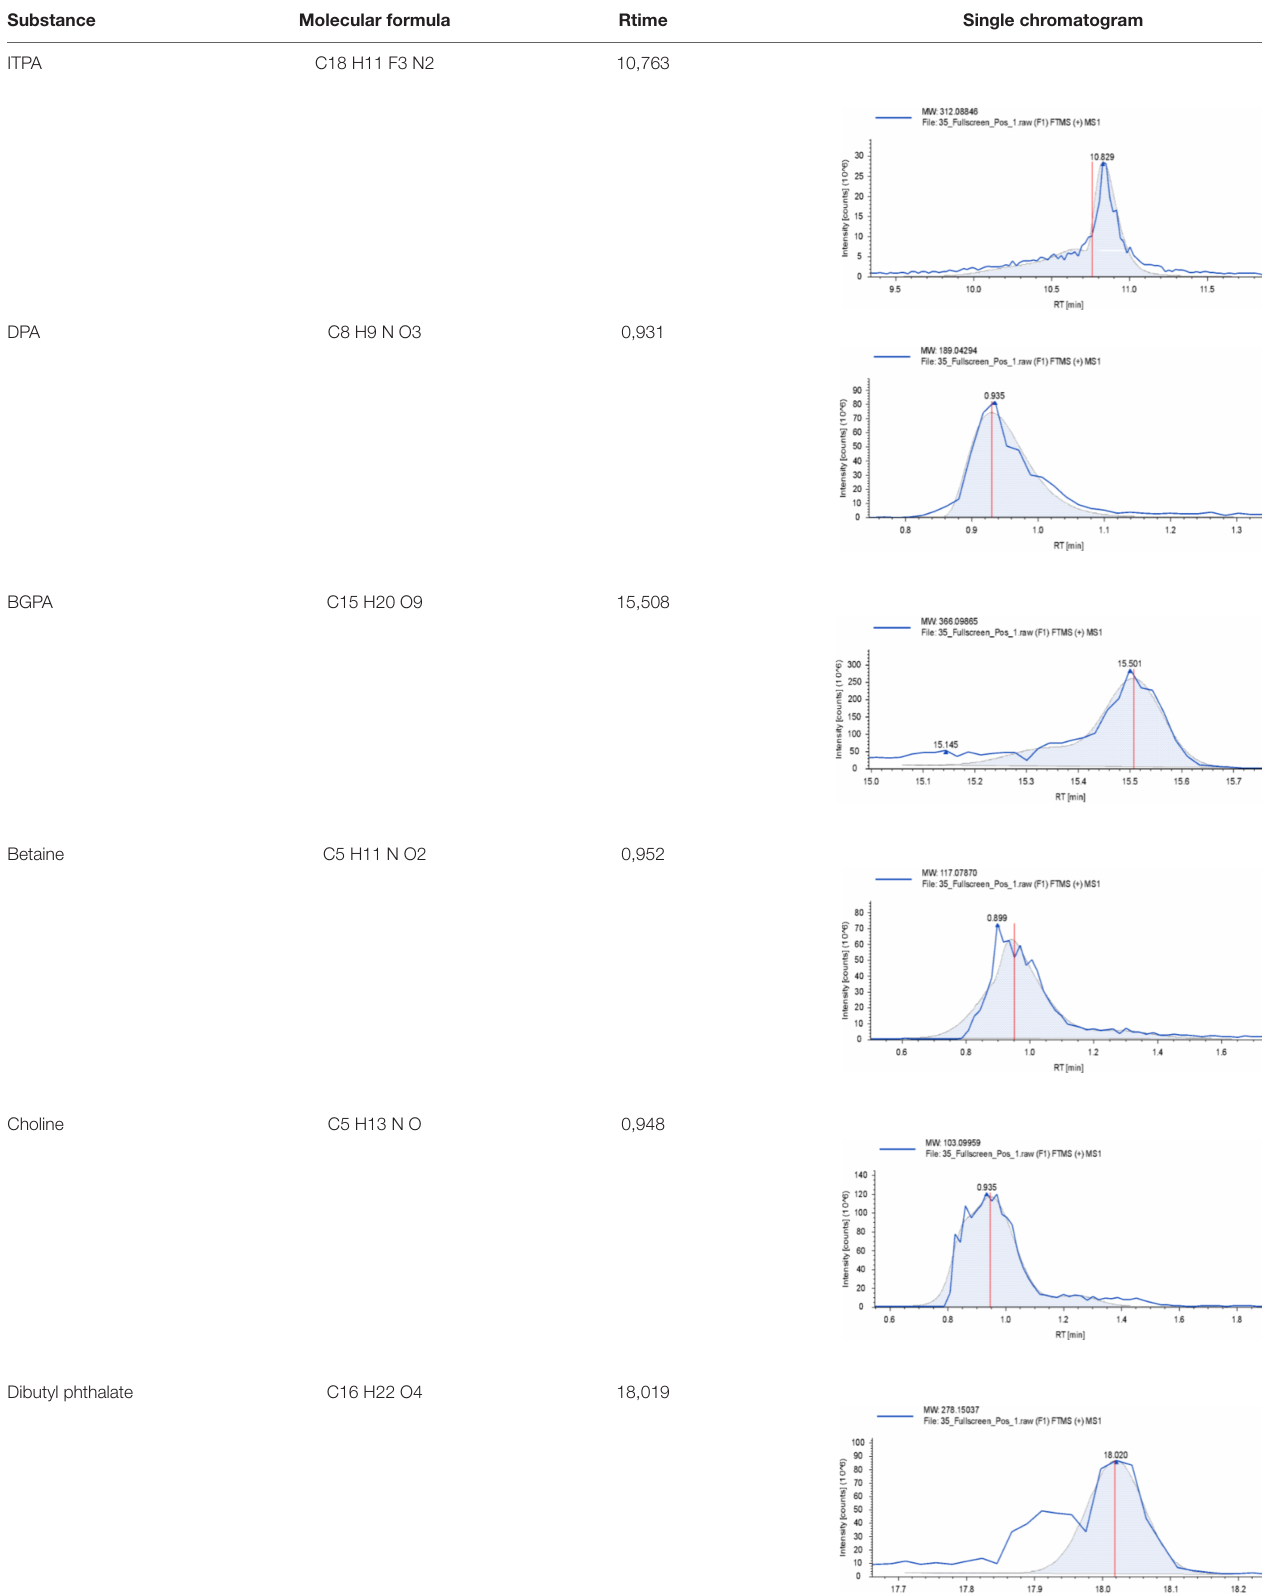
TABLE 1 | Six major compounds based on metabolomic assay of C. racemosa